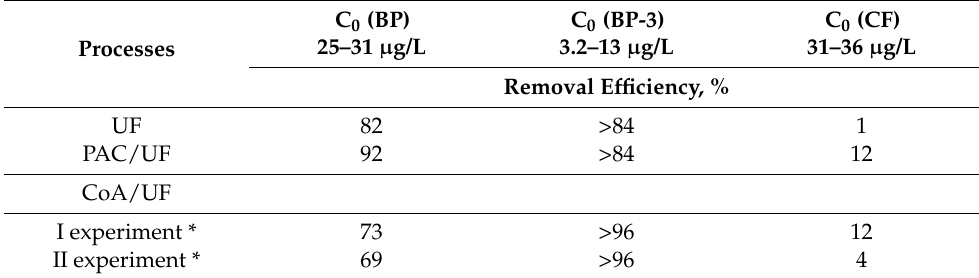
Table 8. Removal efficiency of BPs and CF by hybrid membrane processes. Note—experiment was performed in summer